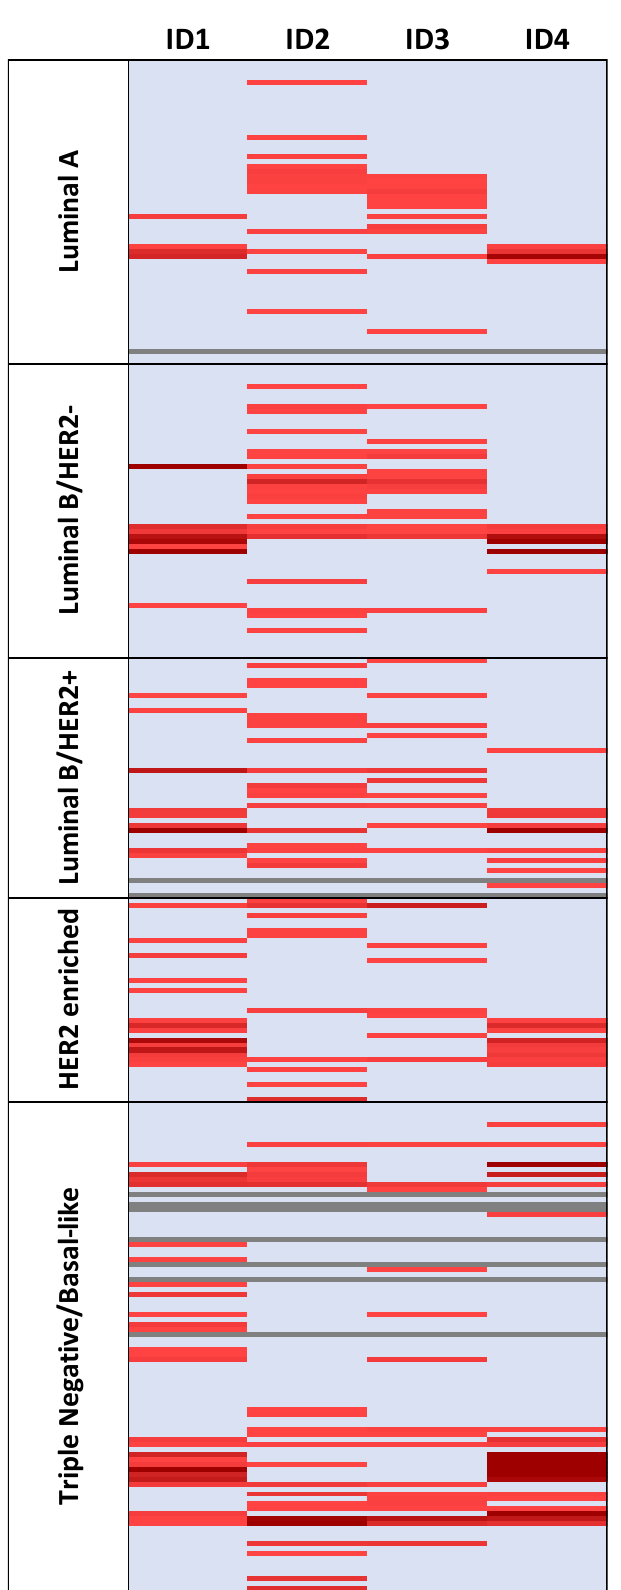
Figure 2. Heat map representing the expression of ID genes in all BC samples ( n = 307) according to BC phenotypes. Normal–low expression (FC < 2) is represented in blue and overexpression (FC ≥ 2) is represented in red. Samples with no available data ( n = 10) are colored